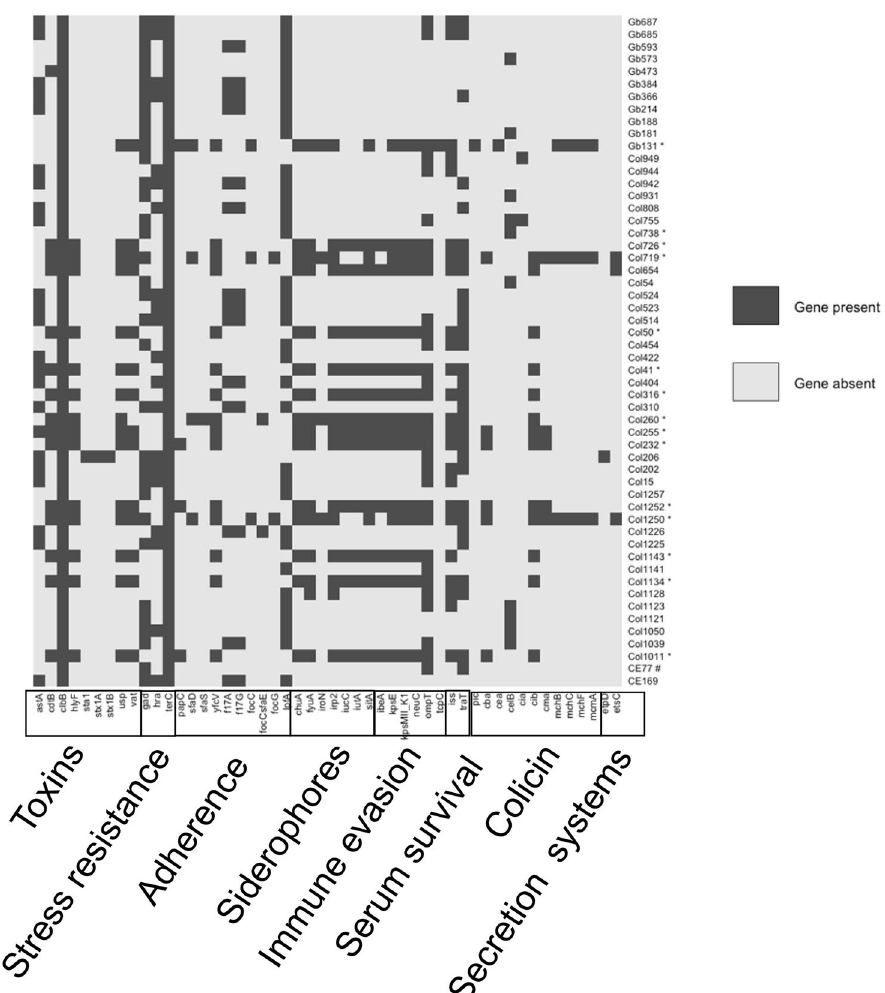
Figure 6. Distribution of acquired virulence genes in clb + E. coli . Heat map was created and visualized using ggplot2 package of R. Column represents E. coli isolates and row represents acquired virulence genes. *, Phylogroup B2; # Phylogroup